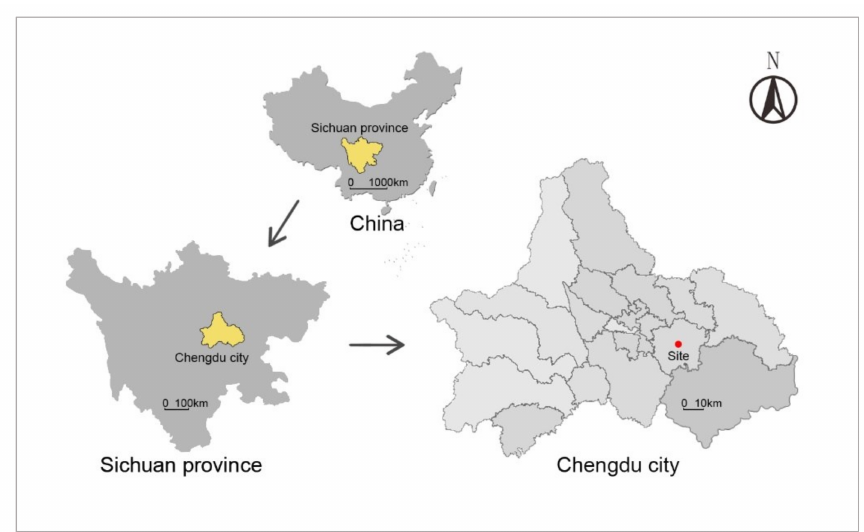
Figure 2. Location of Chengdu